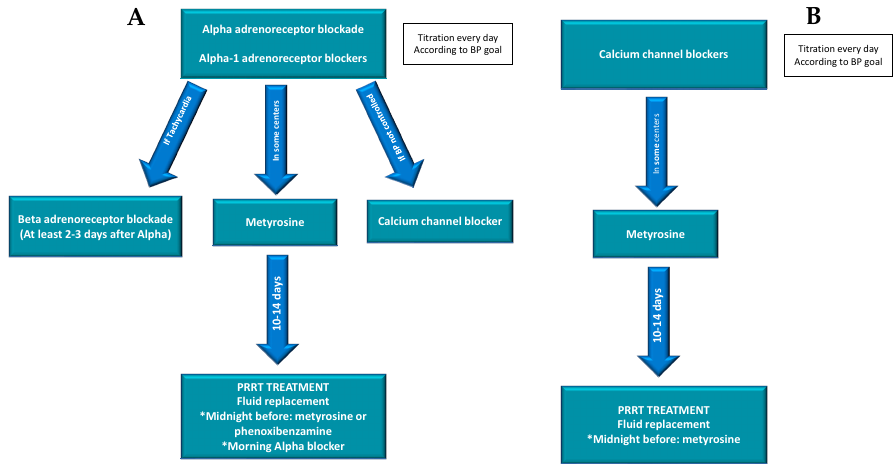
Figure 4. Accepted regimens for preparation of catecholamine producing tumors. ( A ): regimen performed with alpha blockade; ( B ): regimen performed with calcium channel blockers. * specific management for the previous day and day of PRRT: Blood pressure (BP).